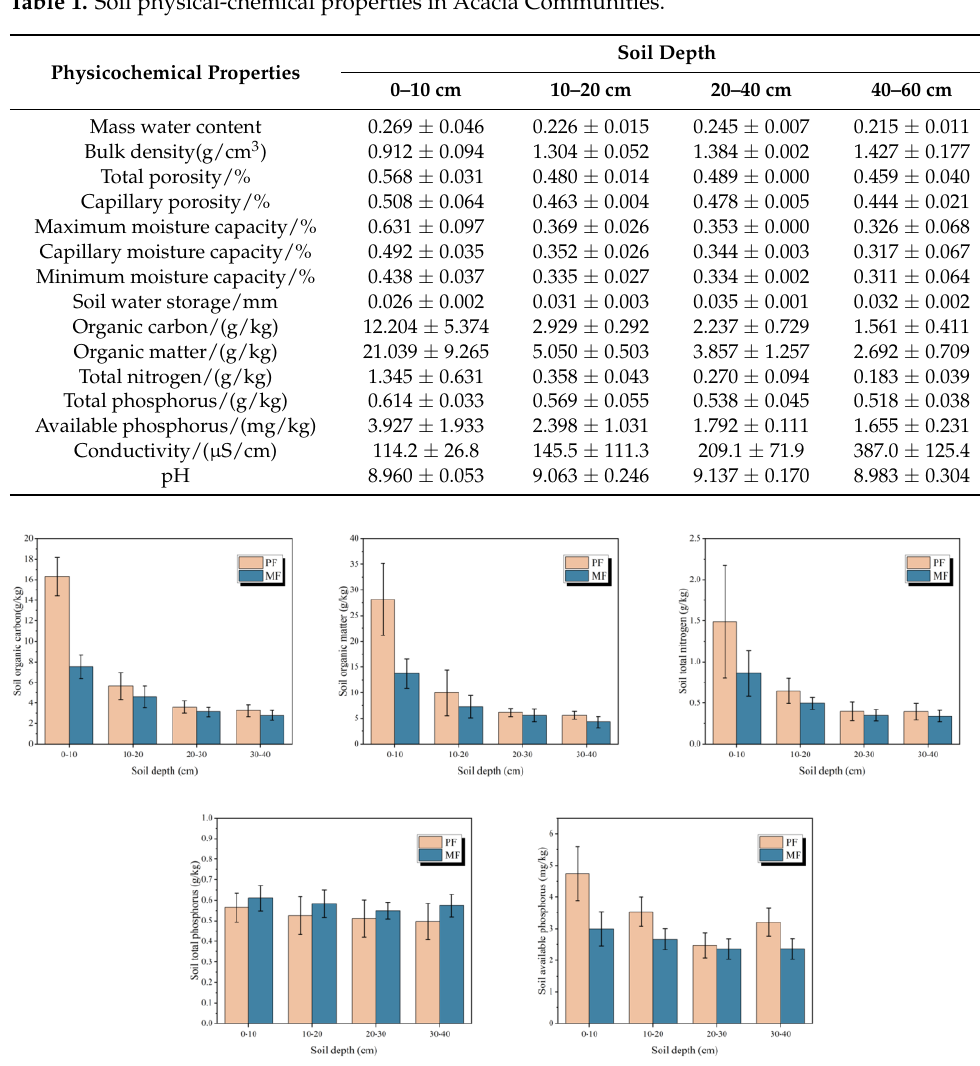
Figure 5. Variation of soil nutrients with depth in preferential flow and matrix flow zones.